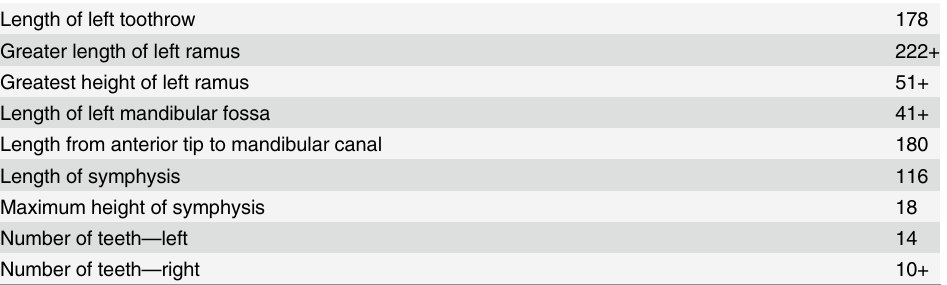
Table 2. Measurements (in mm) of mandible (UF 280000) of Nanokogia isthmia gen. et sp. nov. (modi- fied from Perrin [18]). Length of left toothrow 178 Greater length of left ramus 222+ Greatest height of left ramus 51+ Length of left mandibular fossa 41+ Length from anterior tip to mandibular canal 180 Length of symphysis 116 Maximum height of symphysis 18 Number of teeth — left 14 Number of teeth — right 10+ Abbreviations : + = measurement on incomplete element.